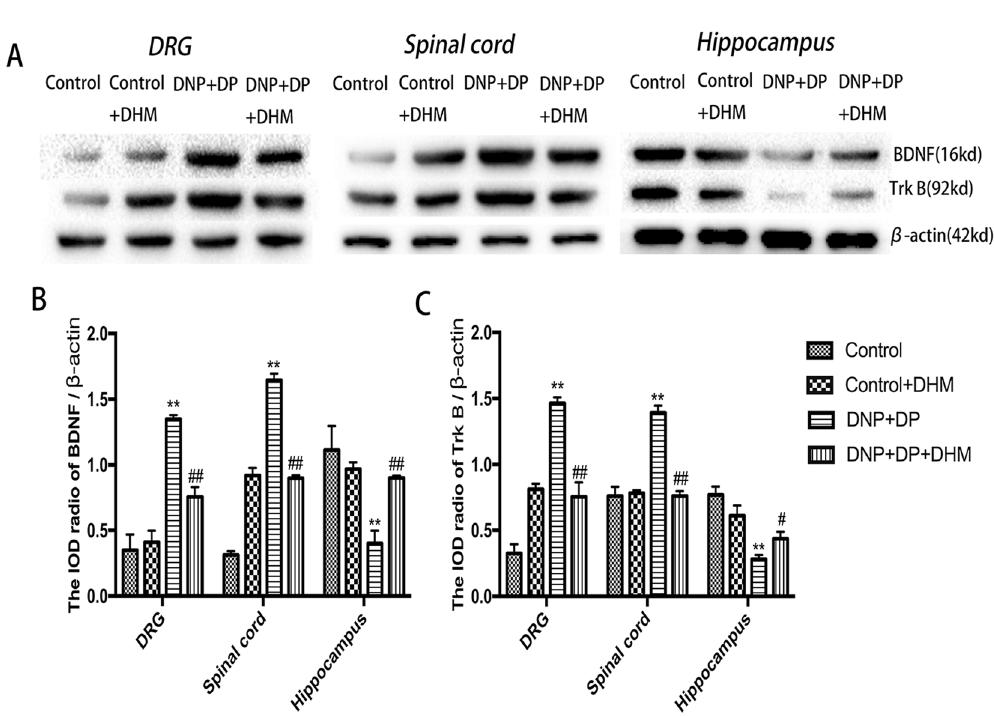
Figure 4. Effects of dihydromyricetin on the expression of BDNF ( A , B ) and TrkB ( A , C ) protein in the DRGs, spinal cord and hippocampus of DNP + DP rats as detected by Western blotting. Values are the mean ± SEM of 6 observations. * p < 0.05 and ** p < 0.01 vs . control group; # p < 0.05 and ## p < 0.01 vs . DNP + DP